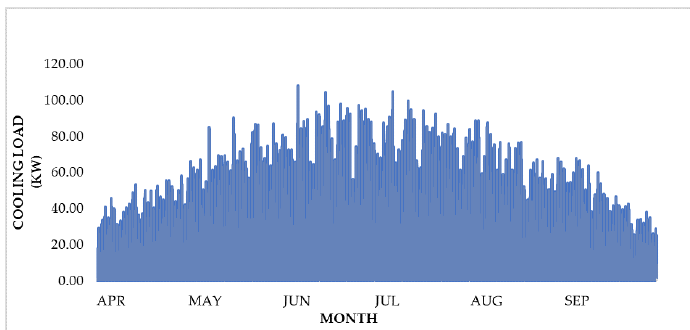
Figure 6. Cooling load